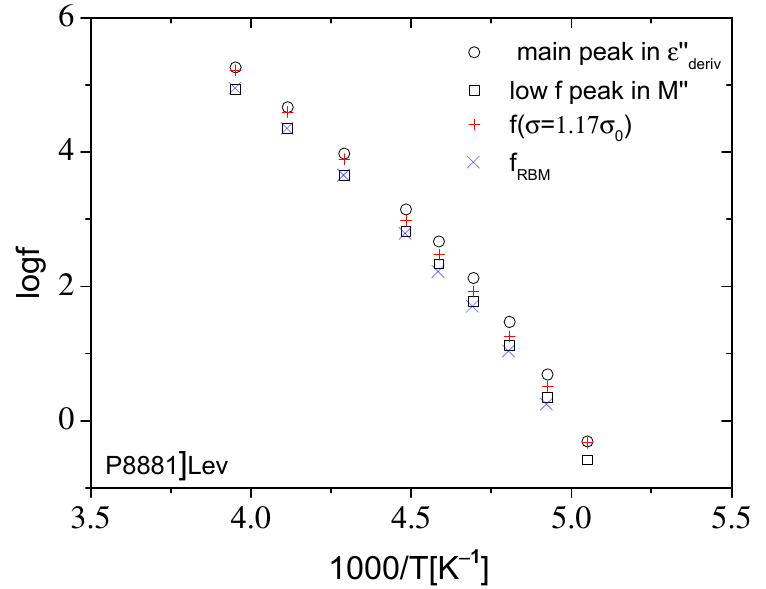
Figure 8 Arrhenius diagram of the characteristic frequencies of the main peak in ε″ deriv and of the low frequency peak in M″ , as well as of the frequency at which σ′ = 1.17σ 0 and of the characteristic frequency f RBM obtained by fitting the expression of the original RBM to σ′(f) data for [N 8881 ]Lev presented in Figure 4.